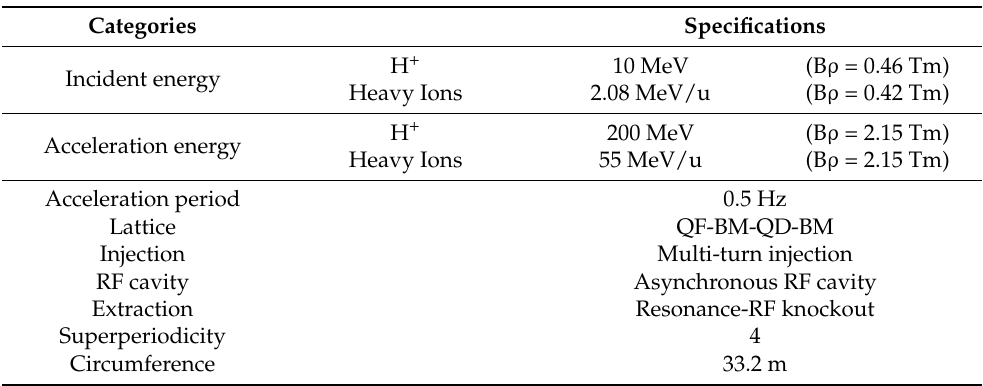
Figure 3 . Synchrotron at WERC. Figure 3. Synchrotron at WERC. Table 2. Specifications of